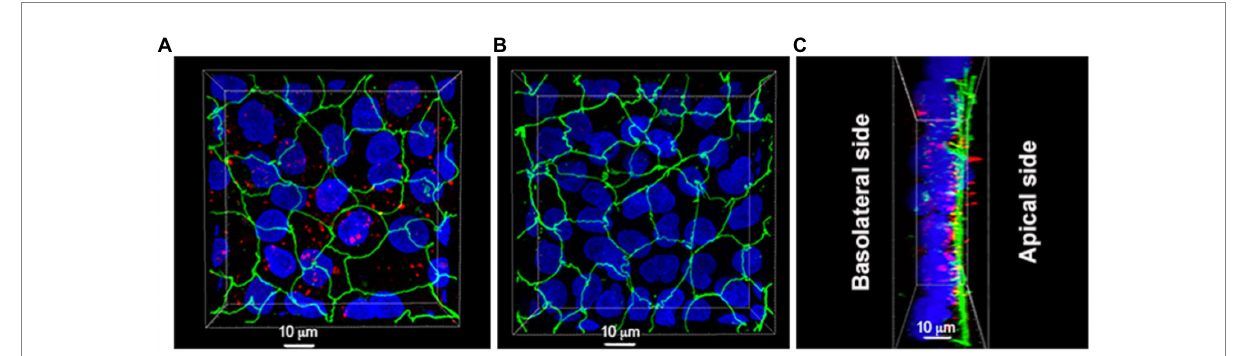
FIGURE 6 Localization of MV derived from L. reuteri DSM 17938 in Caco-2/HT29-MTX cells. (A) Caco-2/HT29-MTX cells were pretreated with MV for 6 h. (B) Caco-2/HT29-MTX cells were pretreated with PBS buffer which was used for resuspension of MV for 6 h. (C) Most of MV were taken up by Caco-2/HT29-MTX cells. Unbound vesicles were washed away prior to the experiment. Images are representatives of four separate experiments, color key: blue = nuclei, green = ZO-1, red =